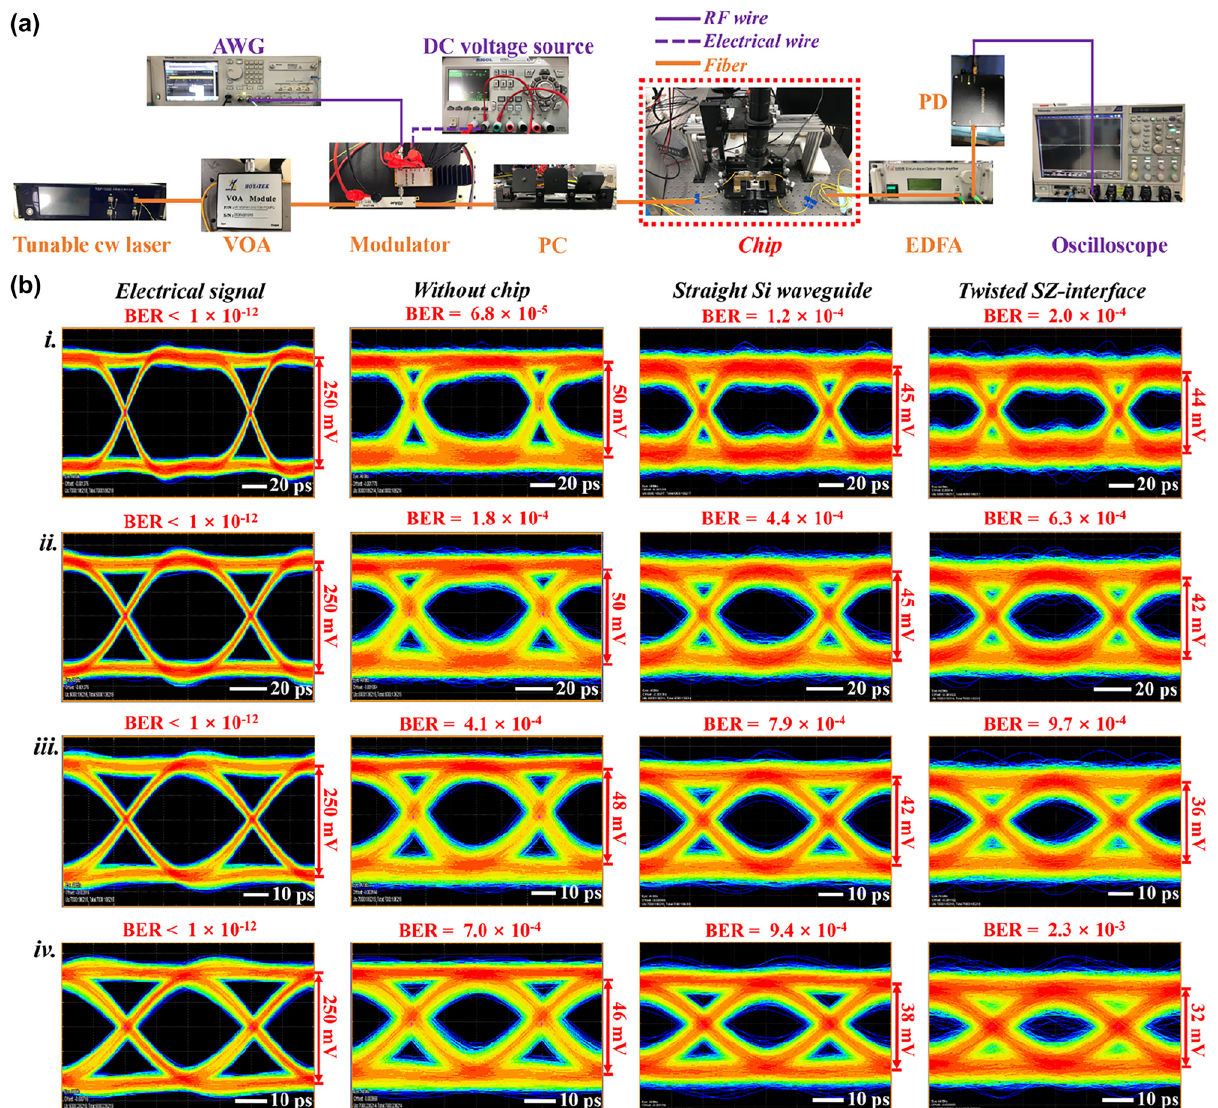
Figure 5: On-chip optical communications. (a) The experimental setup for the optical communication test at 1550 nm. (b) Eye diagrams for the electrical signals generated by AWG (1st column), the data transfers without chip (2nd column), the data transfers in the Z-type domain wall formed by the SZ-interface (3rd column) and the data transfers in the straight Si waveguide (4th column) at data rates of (i) 10, (ii) 15, (iii) 20, and (iv) 25